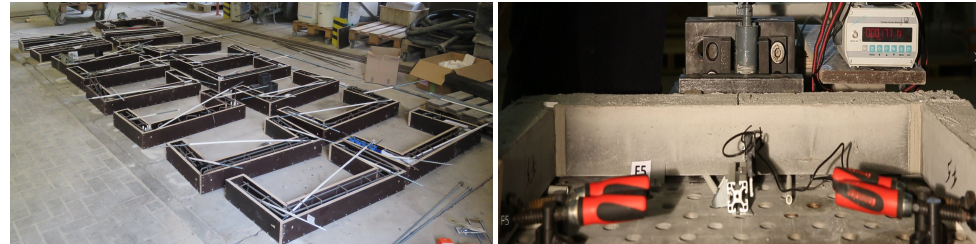
Figure 1. ( Left ) Preparation of the tested frames and ( Right ) testing setup (top beam: 1 m, sides: 0.5 m), recorded with two high-speed cameras.